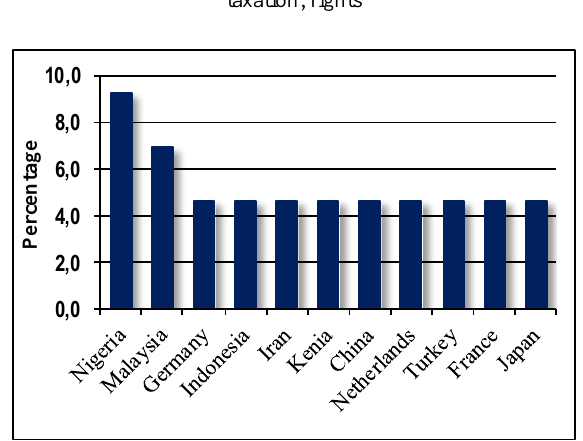
Figure 7. Countries making major contribution in implementation and research related to Spatial Algorithms and Techniques, Processing of Spatial Data